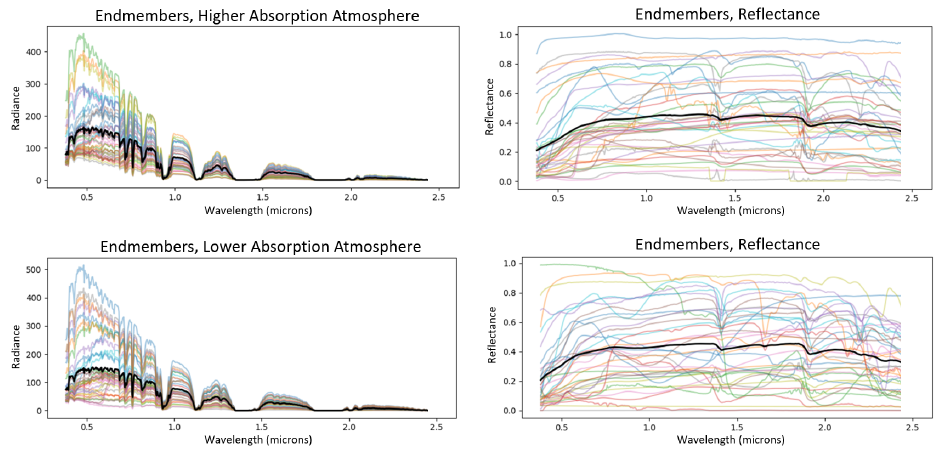
Figure 3. At-sensor radiance for 39 spectra and the mean plotted in black (left-hand plots) along with the true reflectance for these materials and the mean of their reflectance in black (right-hand plots). The top row of plots have an atmosphere with greater absorption and the bottom row has less absorption.